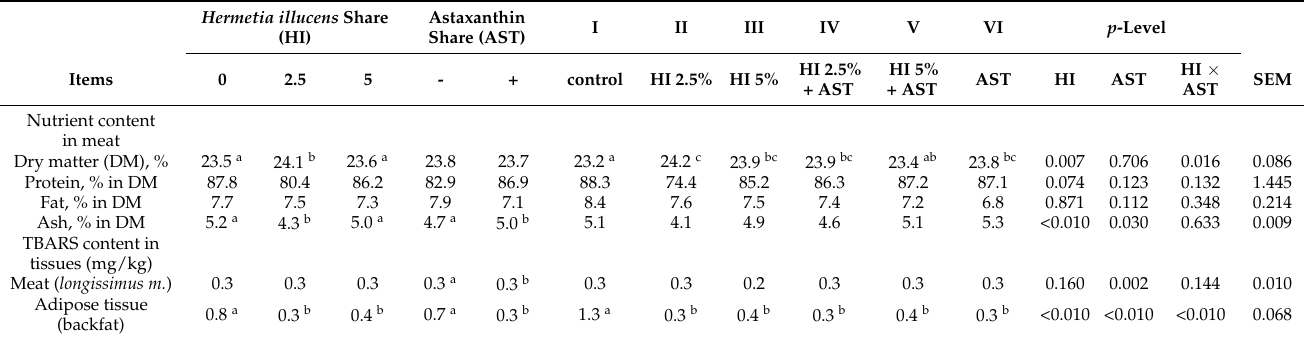
Table 6. Effect of Hermetia illucens meal share and astaxanthin presence in feed on the basic chemical analyses of meat ( longissimus m .) and the oxidative stability of meat and backfat